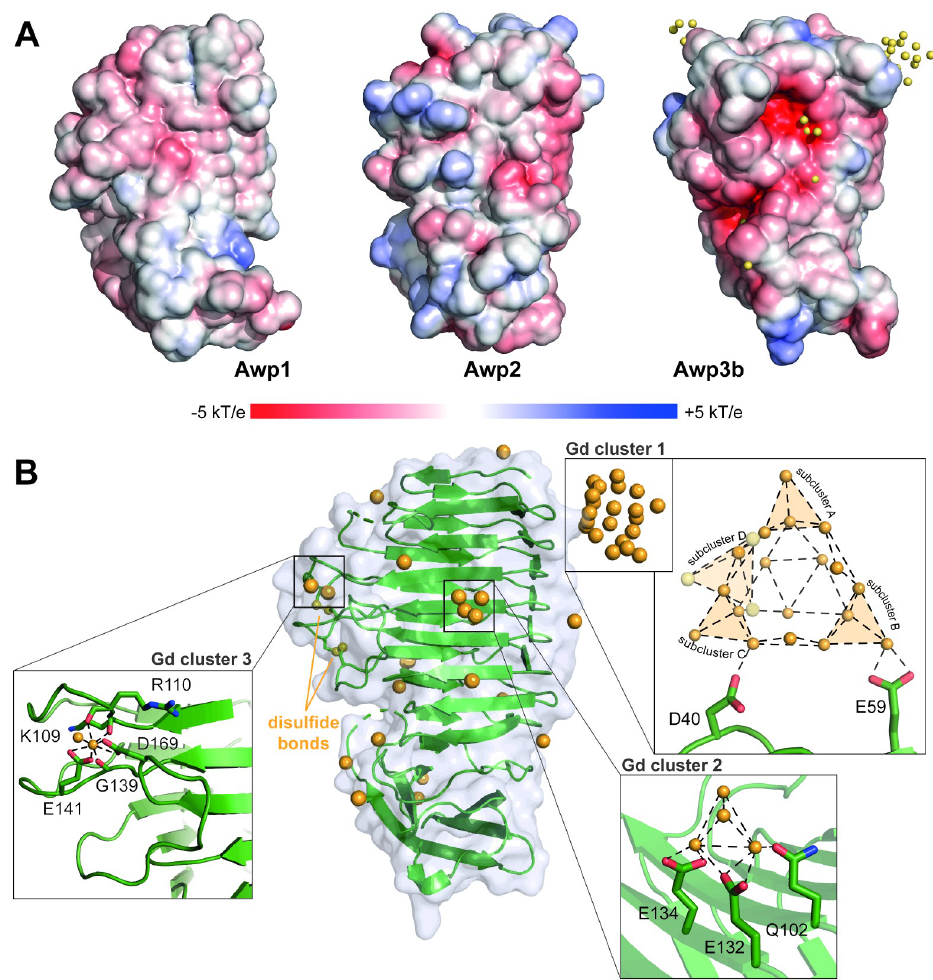
Fig 7. Electrostatics and lanthanide binding by Awp1, Awp2, and Awp3b A-regions. (A) Electrostatic molecular surface potentials of Awp1, Awp2, and Awp3b. The Awp3b surface structure is shown in superposition to the Gd 3+ binding sites of the Awp3b•Gd complex. (B) The 42 Gd 3+ binding sites of the Awp3b•Gd complex. Three Gd 3+ clusters are found on the surface of the β -helix domain, comprising either 21, 4 or two lanthanide ions. Cluster 1 with its 21 Gd 3+ ions is coordinated by only two residues, D40 and E59. It contains four tetrahedral subclusters (A, B, C, and D); subclusters A, B, and C with distances of 3.3–4.1 Å between their Gd 3+ ions are connected to each other by triangular planar clusters composed of three Gd 3+ , with which they form a basket-like shape with three-fold symmetry. Distances of ions participating in composing those triangles range from 3.5 to 4.4 Å . Subcluster D is associated to the basket-like shape via a single Gd 3+ ion. Atoms in this subcluster are a bit further apart from each other when compared to other tetrahedral clusters, namely 3.7–4.4 Å . Cluster 2 with four Gd 3+ ions forms a regular tetrahedron that is connected to the protein via Q102, E132 and E134. Distances between the Gd 3+ ions range from 2.8 to 3.8 Å , and the Gd 3+ ions are 2.4 Å away from the carboxyl group O of the coordinating residues. Tetrahedral geometries of lanthanide clusters have been reported previously for complexes of the S . cerevisiae Flo5 A-domain with Gd 3+ [38]. Such clusters are of high interest for the development of novel contrast agents in magnetic resonance imaging